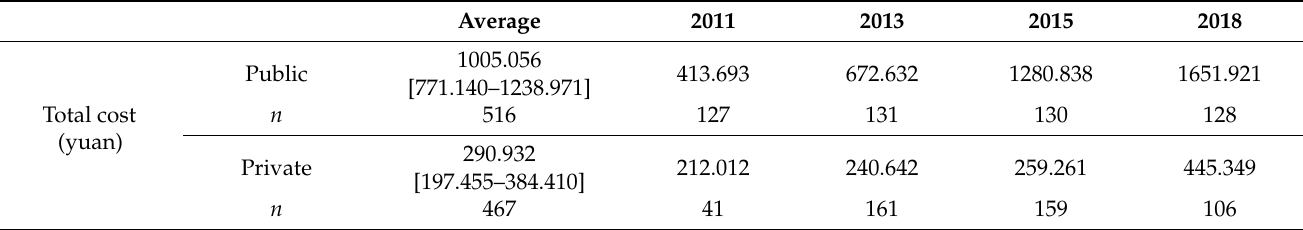
Table 2. Descriptive statistics of health costs and related